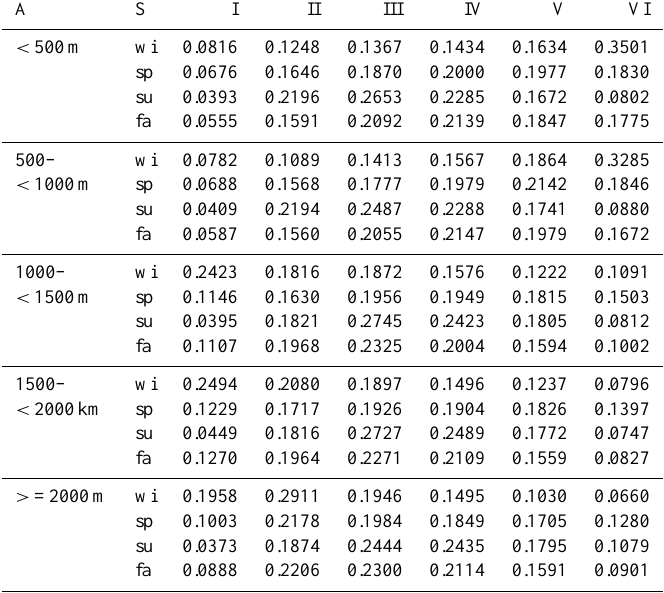
Table D2. Probabilities of cloud coverage classes for a 24h precipitation sum of 0cm depending on explanatory variables following selected Swiss climate weather stations. A: altitude of the climate stations; S: season; wi: winter (before day 46 or after day 319 of a year); sp: spring (between days 46 and 136 of a year); su: summer (between days 137 and 227 of a year); fa: fall (between days 228 and 318 of a year); I–IV: